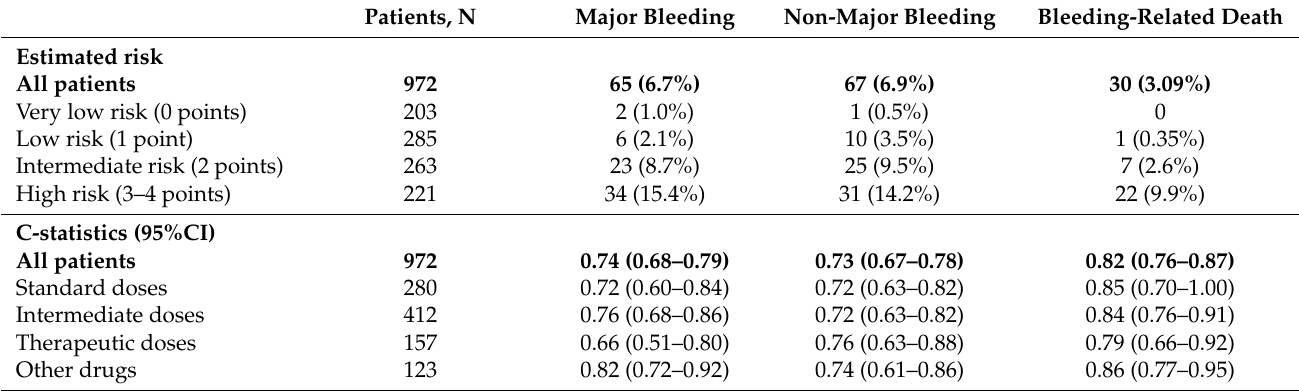
Table 4. Proportion of patients developing bleeding complications according to the prognostic score. The score assigns 1 point for each of the following: ICU admission, D-dimer levels > 10 times over the upper limit, ferritin levels > 500 ng/mL and use of therapeutic anticoagulation.